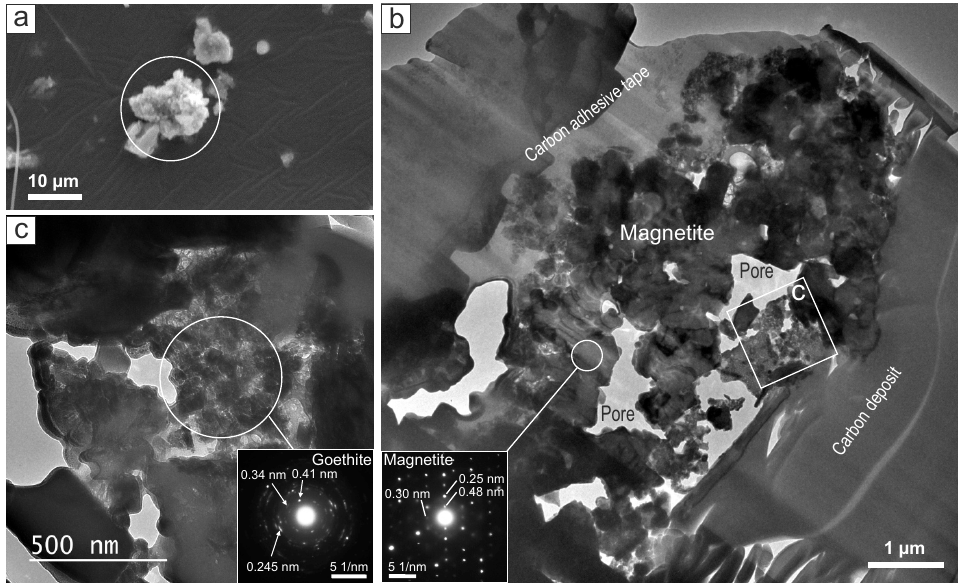
Figure 12. Iron-oxide-rich dust particle from 2012 Asian dust. (a) SEM image of the dust particle. (b) Overall TEM image of the FIB slice prepared from the particle in (a) . (c) TEM image magnified from the box in (b) . Electron diffraction patterns of the circled areas in (b) and (c) indicate goethite and magnetite,